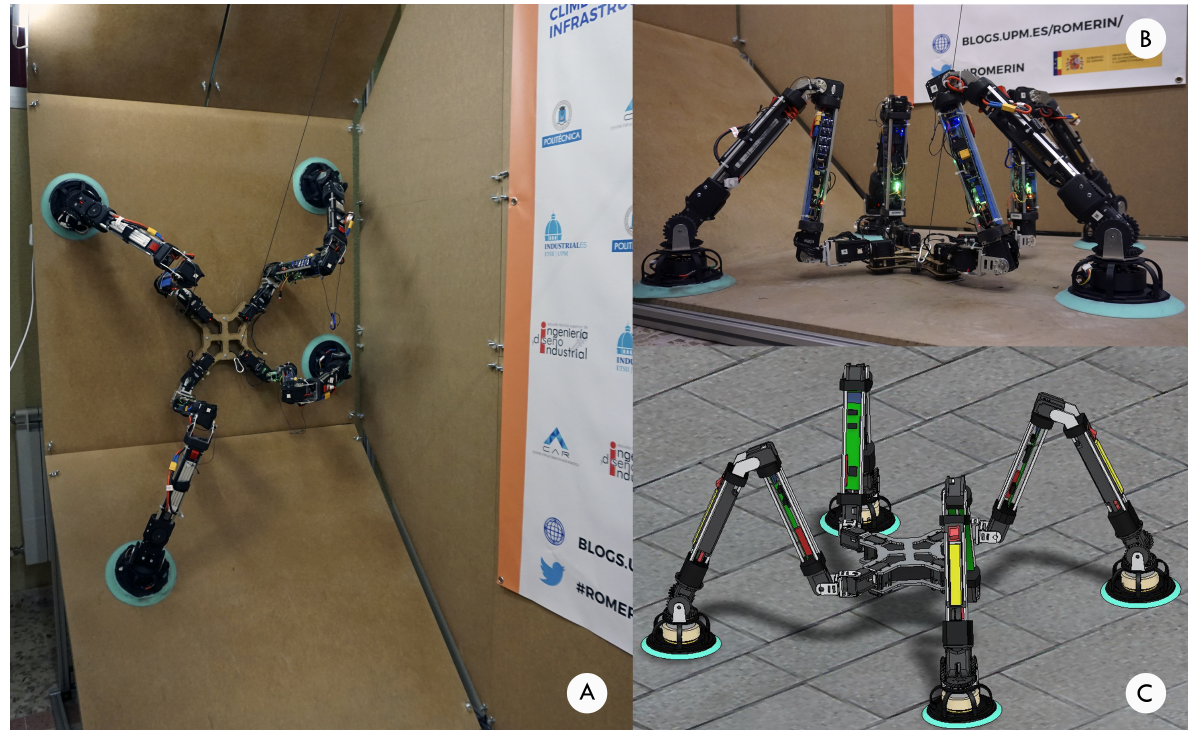
Figure 1. ( A ) Romerin modular robot stuck to the vertical wall of the test bench. ( B ) View of the robot starting up on the ground. ( C ) Romerin virtual